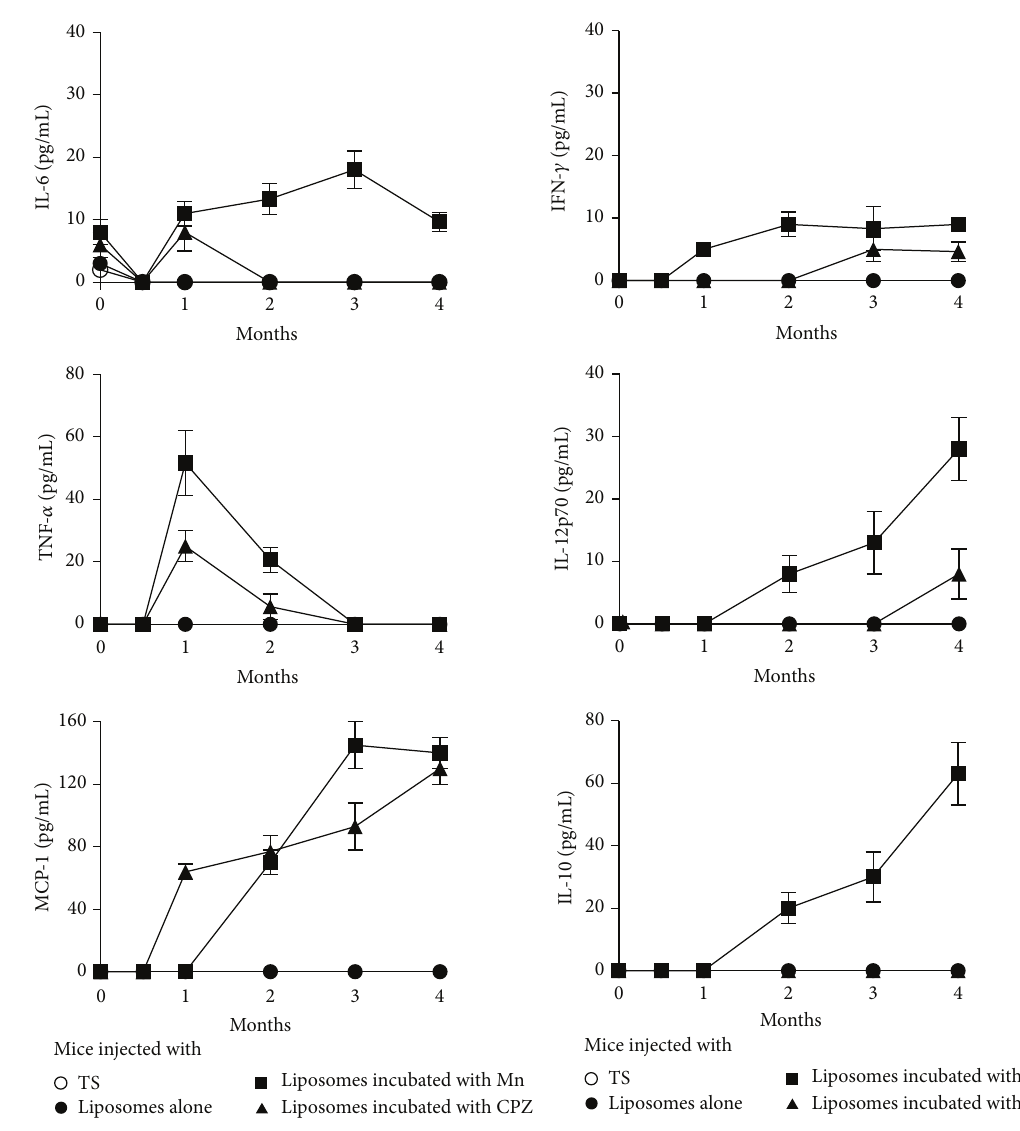
Figure 4: Proinflammatory cytokines are found in the sera of mice with the disease resembling human lupus. Cytokines were detected in the sera of mice injected with egg-yolk phosphatidylcholine/egg-yolk phosphatidic acid (2:1) liposomes (50nmol phosphatidic acid in 50 𝜇 L TS buffer) incubated with 5 mMMnCl 2 or 3mM chlorpromazine (CPZ). Months indicate the time after the first injection of liposomes. The detection limits for each cytokine were 5pg/mL IL-6, 7.3 pg/mL TNF- 𝛼 , 52.7 pg/mL MCP-1, 2.5 pg/mL IFN- 𝛾 , 10pg/mL IL-12p70, and 17.5pg/mL IL-10. Control groups (mice injected with TS buffer or with liposomes without nonbilayer phospholipid arrangements) did not have detectable levels of these cytokines. Bars represent the mean ± SD of three independent experiments with six mice